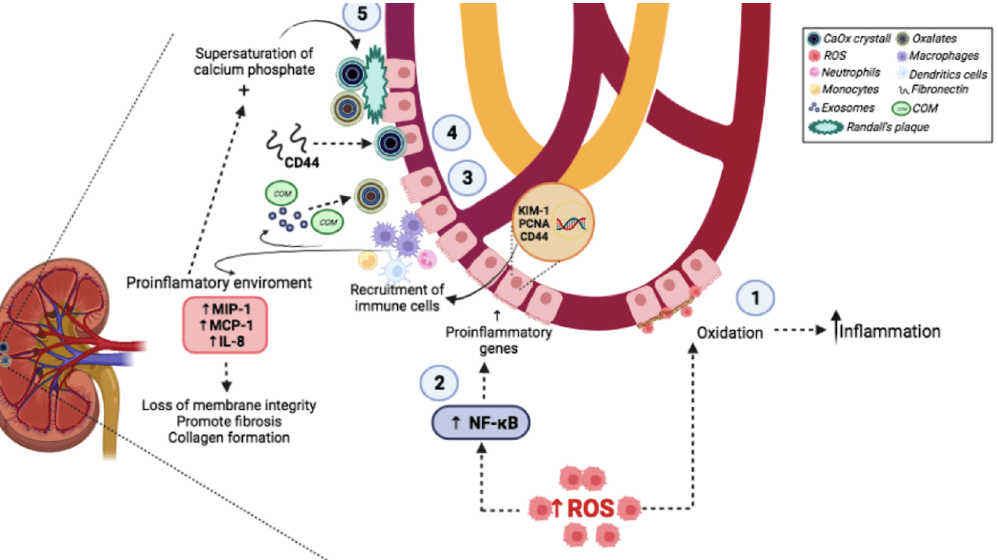
Figure 1. Molecular mechanisms involved in the formation of urinary stones. (1) Excessive ROS levels promote oxidation of renal cell membrane components, and this causes biochemical alterations. (2) Overexpression of pro-inflammatory genes through NF- κ B by ROS. (3) Injury in kidney by chemokines and immune cells such as monocytes, macrophages, and neutrophils. (4) Macrophages in development of CaOx crystals. (5) Pro-inflammatory state and oxidative damage induces Randall’s plaque formation by progressive supersaturation of calcium phosphate induction.